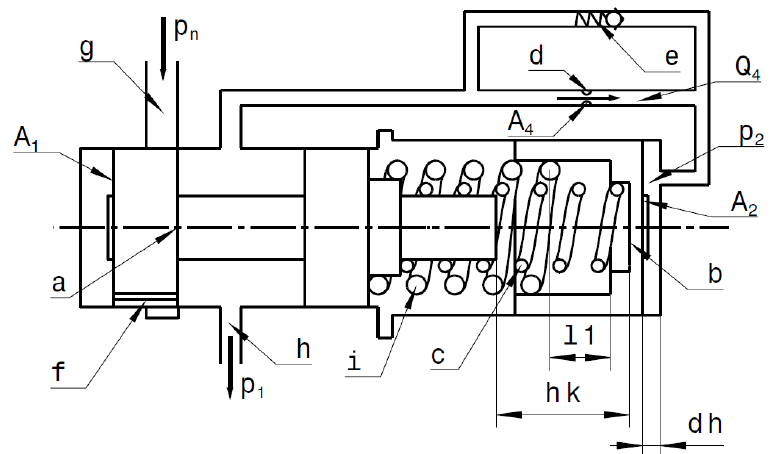
Figure 1 – Positions of the hydraulic buffering valve elements at the beginning of the pressure modulation process Рис. 1 – Положение деталей модулятора давления в начале процесса